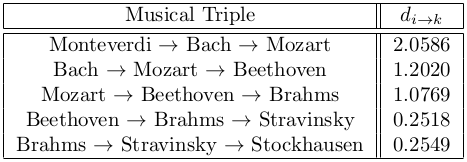
Table from the paper: Can the evolution of music be analyzed in a quantitative manner?
Table text:
MusicalTriple
d i → k
Monteverdi → Bach → Mozart
2.0586
Bach → Mozart → Beethoven
1.2020
Mozart → Beethoven → Brahms
1.0769
Beethoven → Brahms → Stravinsky
0.2518
Brahms → Stravinsky → Stockhausen
0.2549